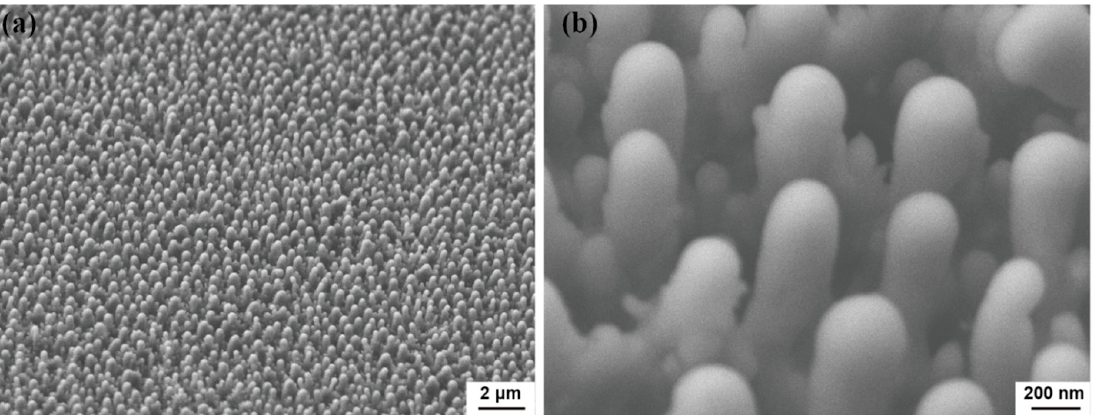
Figure 2. 45-degree view FESEM images of silicon foil. ( a ) Region with laser irradiation in water at low-magnification, ( b ) region with laser irradiation in water at high-magnification.